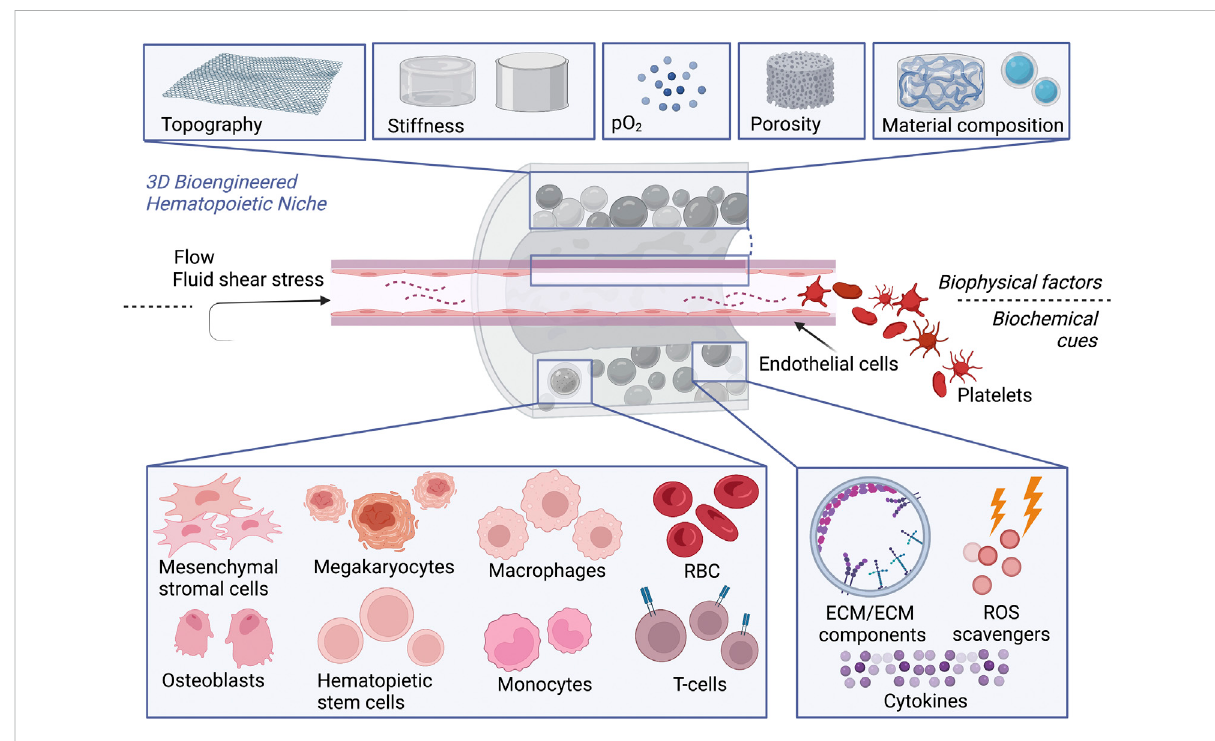
FIGURE 2 3D bioengineered hematopoietic niche in vitro . To promote HSCs expansion and differentiation or improve platelet production by megakaryocytes, scaffolds recreating the hematopoietic niche should offer simultaneously: 1) Physical cues, given by the composition of the biomaterial, topography, stiffness, oxygen tension, porosity, fl uid shear stress. 2) Biochemical cues, provided either by the presence of cell monoculture or multi-culture or cellular components as ECM or ECM components (e.g., RGD peptides) to facilitate the homing of HSCs and